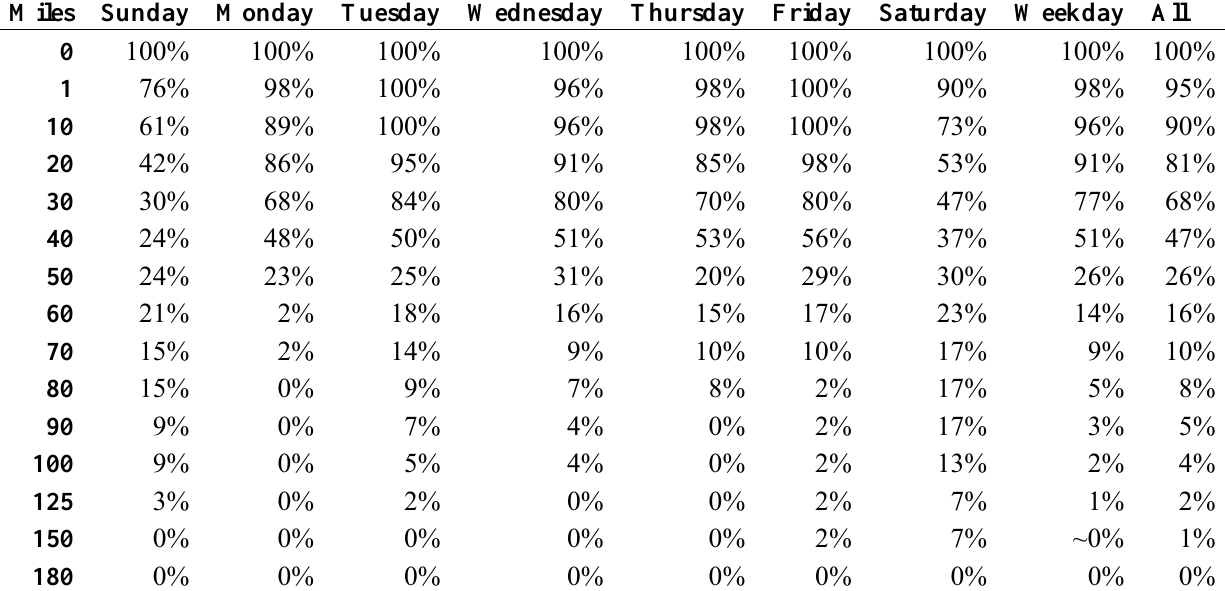
Table 4. Percentage of days exceeding a given daily driving distance (% of days, travel days only